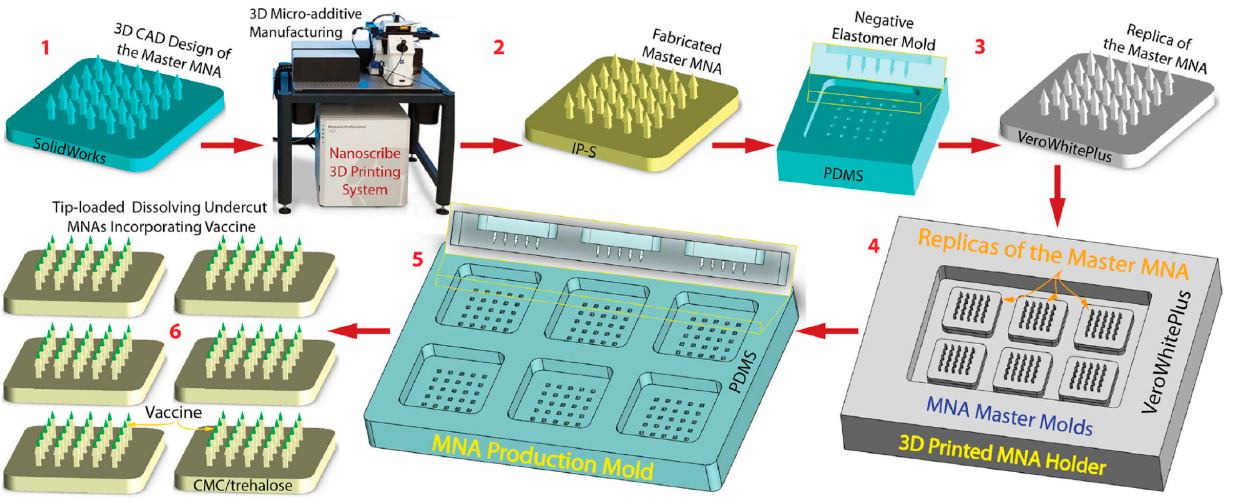
Figure 4. Dissolving microneedle array manufacturing strategy via micromolding (taken from [276]).